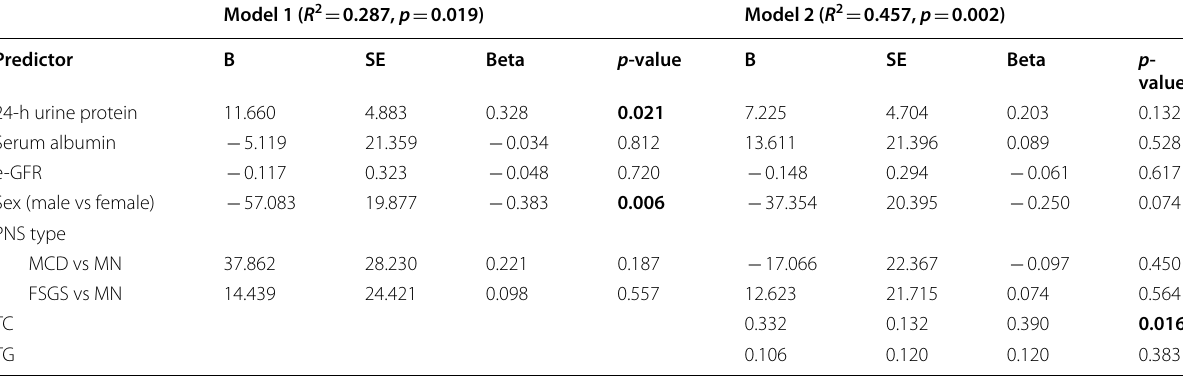
B Unstandardized coefficient, SE Standard error, Beta Standardized coefficient